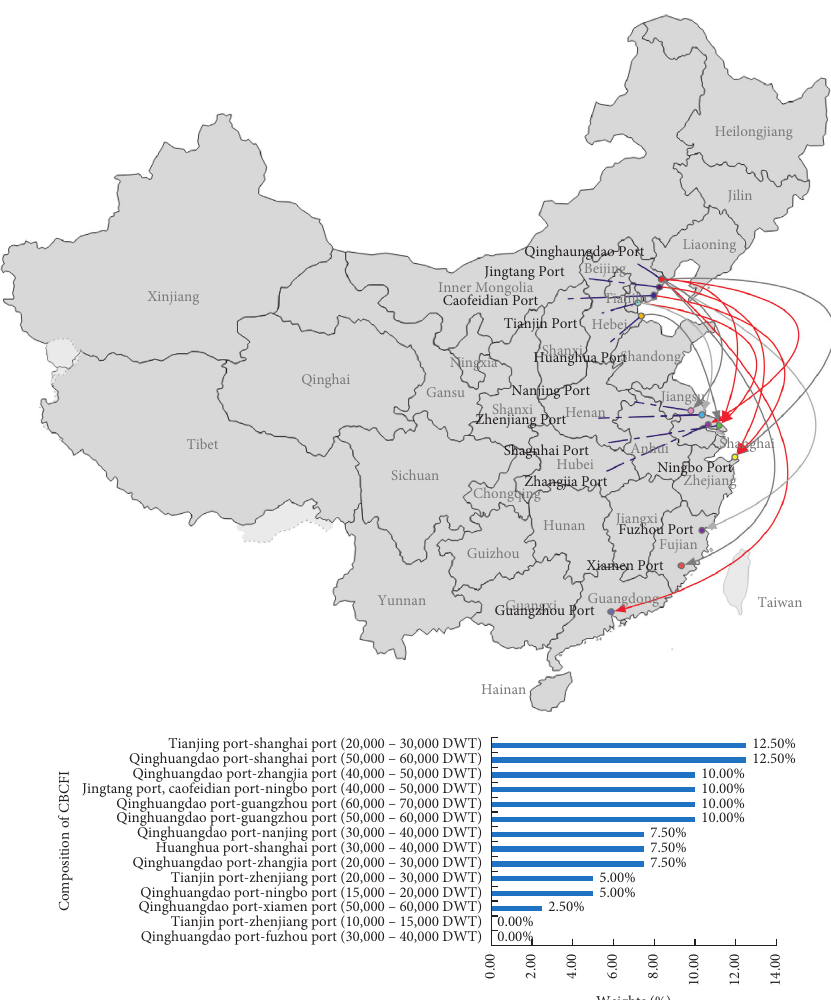
Figure 1: Illustration of the CBCFI composition and the corresponding shipping routes (DWT in bracket represents the “deadweight tonnage (DWT)” of the